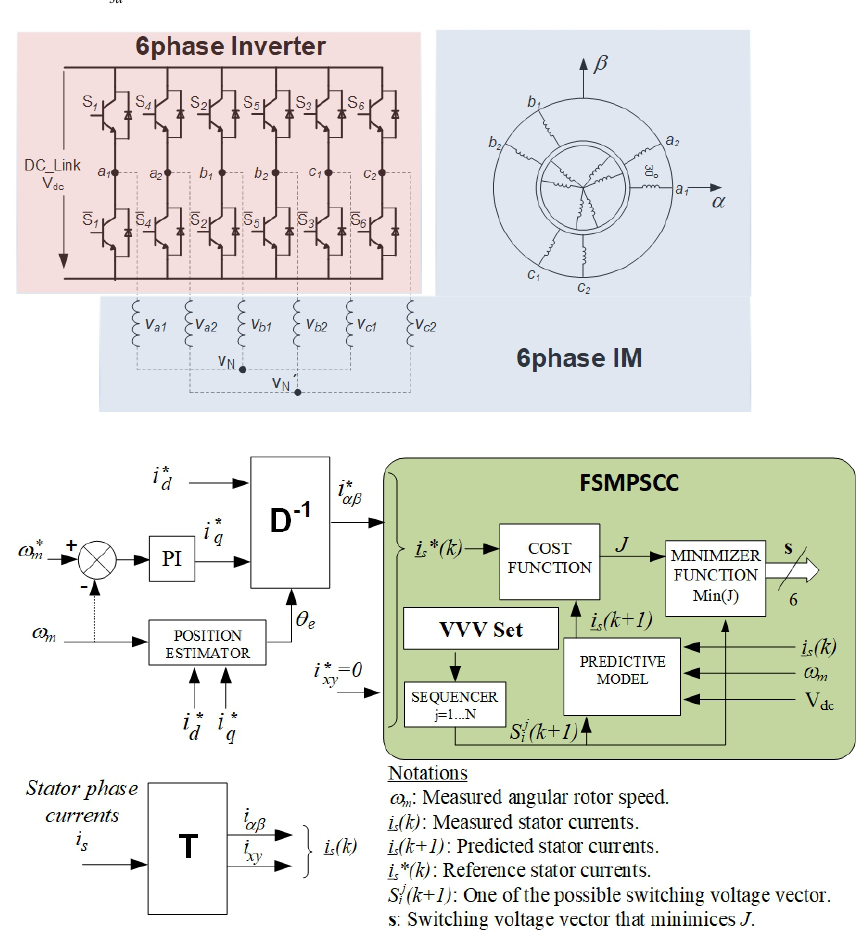
Figure 1. Diagram of FSMPSCC of a 6-phase IM using a single VVV